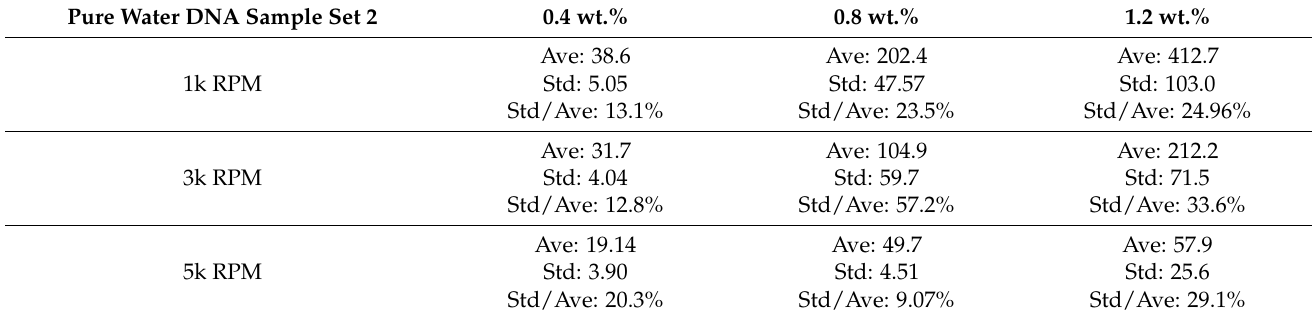
Table 3. Average thickness (nm) and standard deviation (nm) from 5 × 5 measurements of 0.5:2 MeOH/H 2 O DNA solution. An amount of 2 mL of aqueous DNA with varying DNA concentration solutions diluted with 0.5 mL of methanol solvent. 0.5:2 (MeOH/H 2 O) 0.4 wt.% + 25% Volume of MeOH